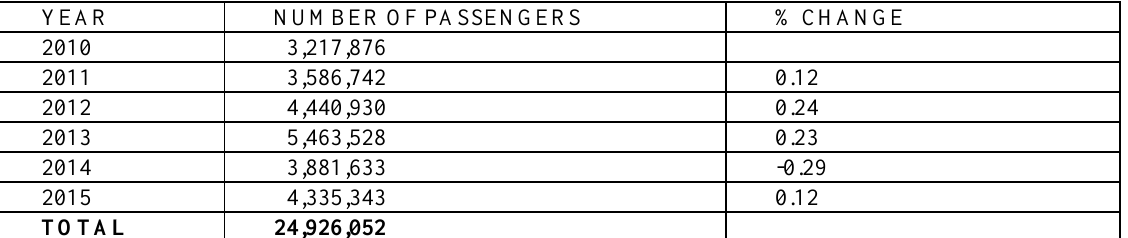
Table 2. Total international air passenger movement in Nigeria.